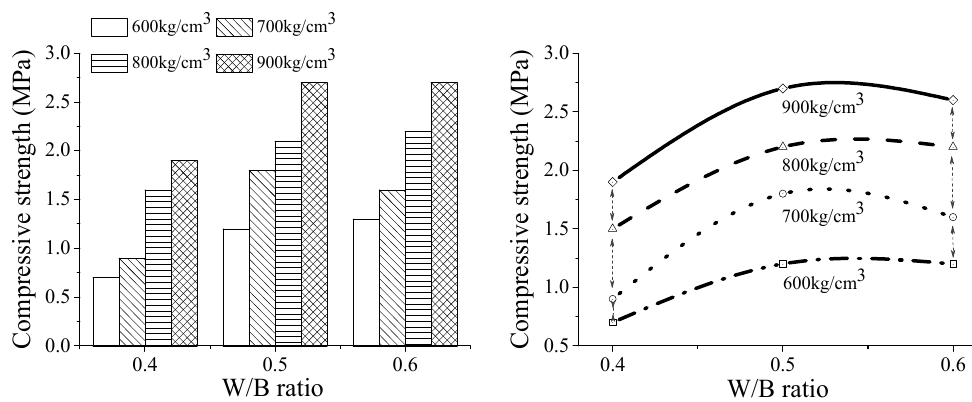
Figure 4. Effect of water-to-binder ratio on the compressive strength of the foam backfill material at different density grades.